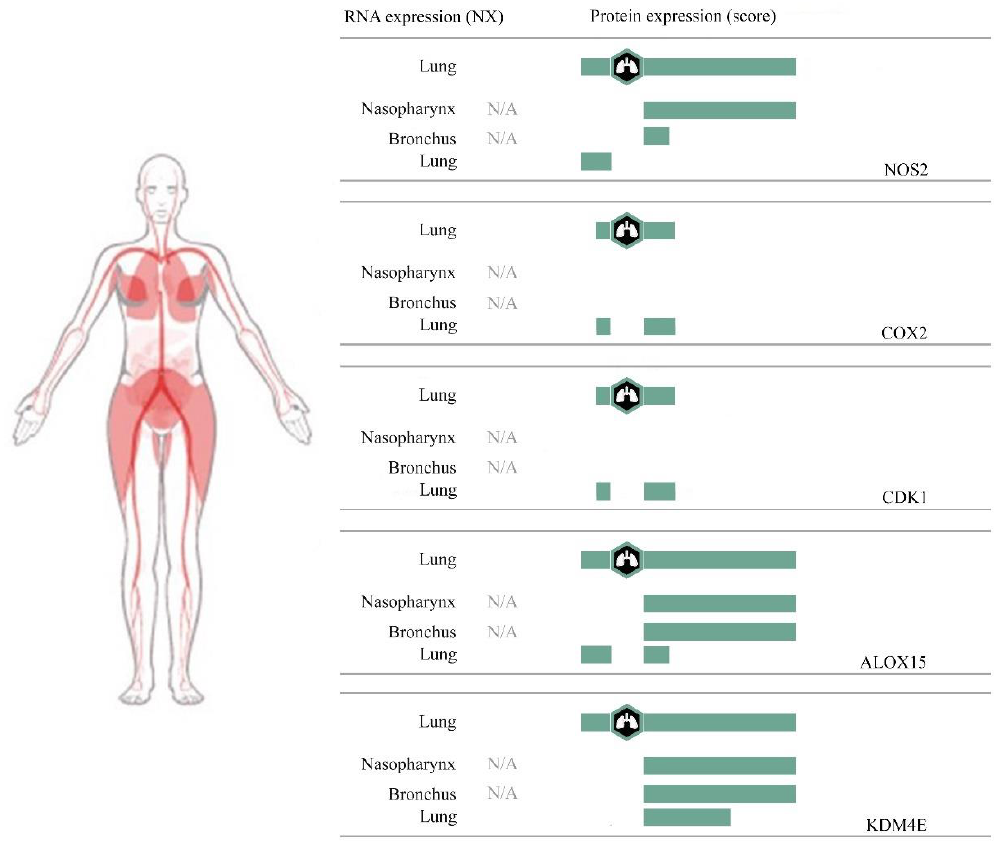
Figure 5. The expression of nitric oxide synthase 2 (NOS2), cyclooxygenase 2 (COX2), cyclin-dependent kinase 1 (CDK1), arachidonate 15-lipoxygenase (ALOX15), and lysine-specific demethylase 4E (KDM4E) in human respiratory segments.